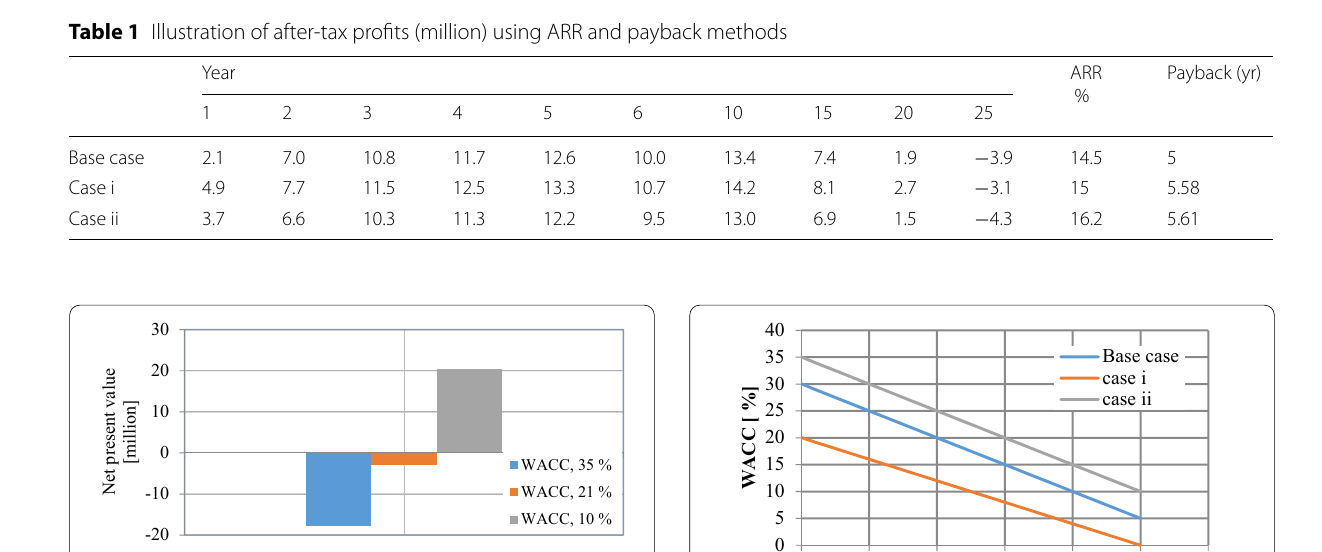
Fig. 10 Comparison of net present values for project at different weighted average costs of capital